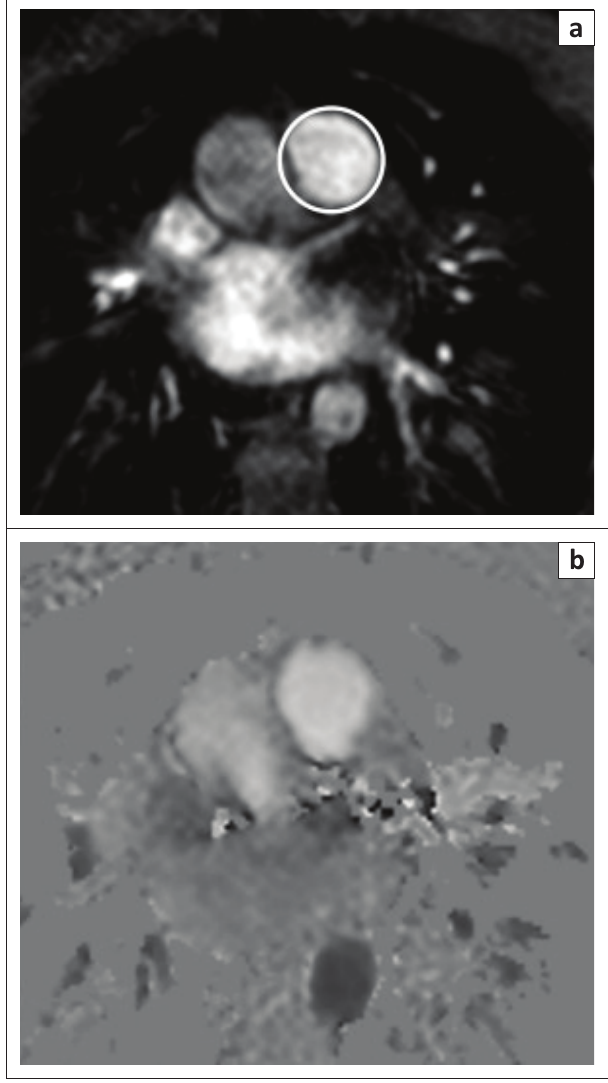
FIGURE 12: Phase contrast images perpendicular to the pulmonary valve. The phase contrast series generates two sets of images: the magnitude image: (a) that clearly defines the anatomical structure, and (b) the phase contrast image that depicts the blood flow with less anatomical detail. When performing contours, it is advisable to draw the ROI on the magnitude image (white contour) and then to propagate them to the phase contrast